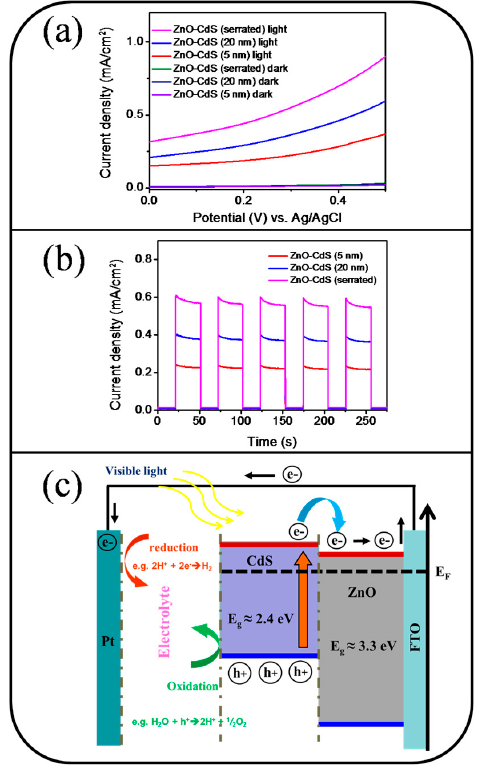
Figure 7. ( a ) Current density vs. potential curves for various nanorod samples with and without visible-light illumination; ( b ) cyclic current density vs. time curves for various nanorod samples under chopped visible-light illumination; ( c ) illustration of band alignment and charges transfer of the ZnO-CdS heterostructure under visible-light illumination.